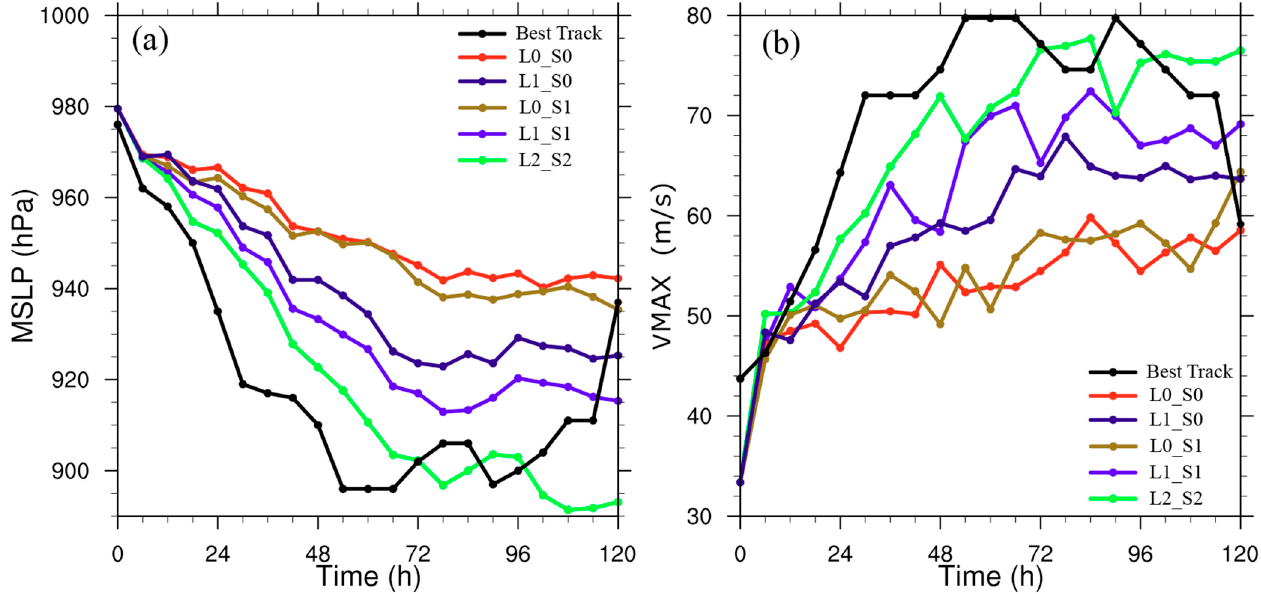
Figure 10. Along-track( a ) MSLP and ( b ) VMAX from five numerical experiments and the JTWC best track data.